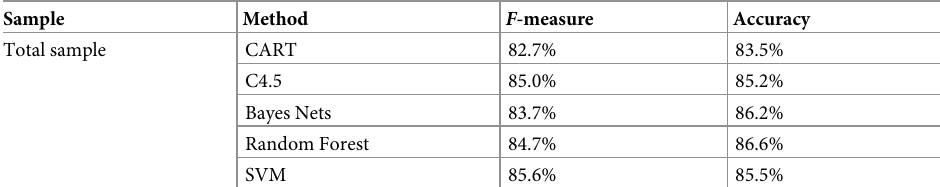
Table 4. Performance of each method for the total sample.